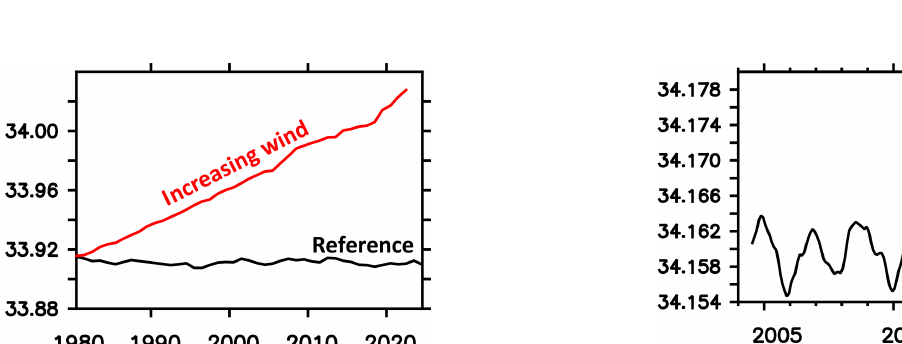
Figure 16. Climatological mean sea surface salinity in psu. WOA09, Argo (2004–2017 period) and SMOS in the upper panels refer to observations compiled by Antonov et al. (2009), Roemmich and Gilson (2009) and Köhler et al. (2015), respectively. MOMSO in the lower panel refers to an average over the nominal 1993–1998 period of the reference simulation. MOMSO-WOA09 and MOMSO-Argo refer to sea surface salinity differences between the reference simulation and respective observations.